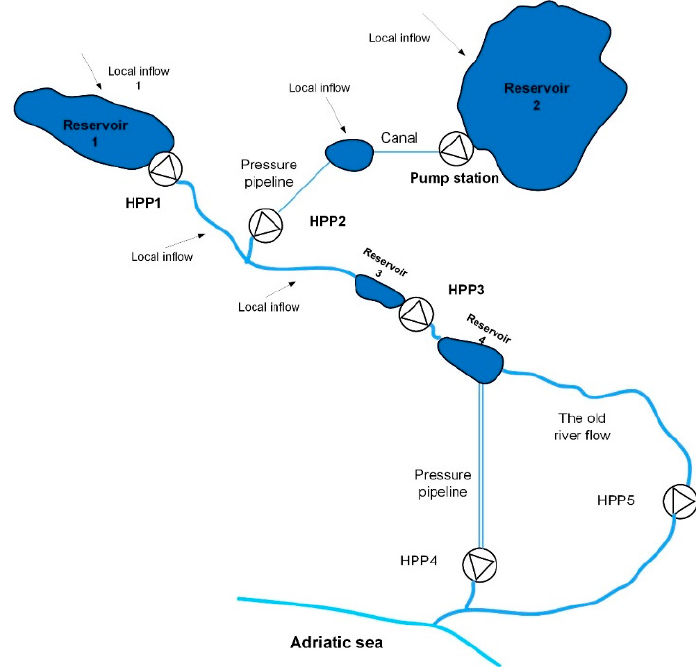
Figure 9. An observed hydrological system with five cascaded HPPs.